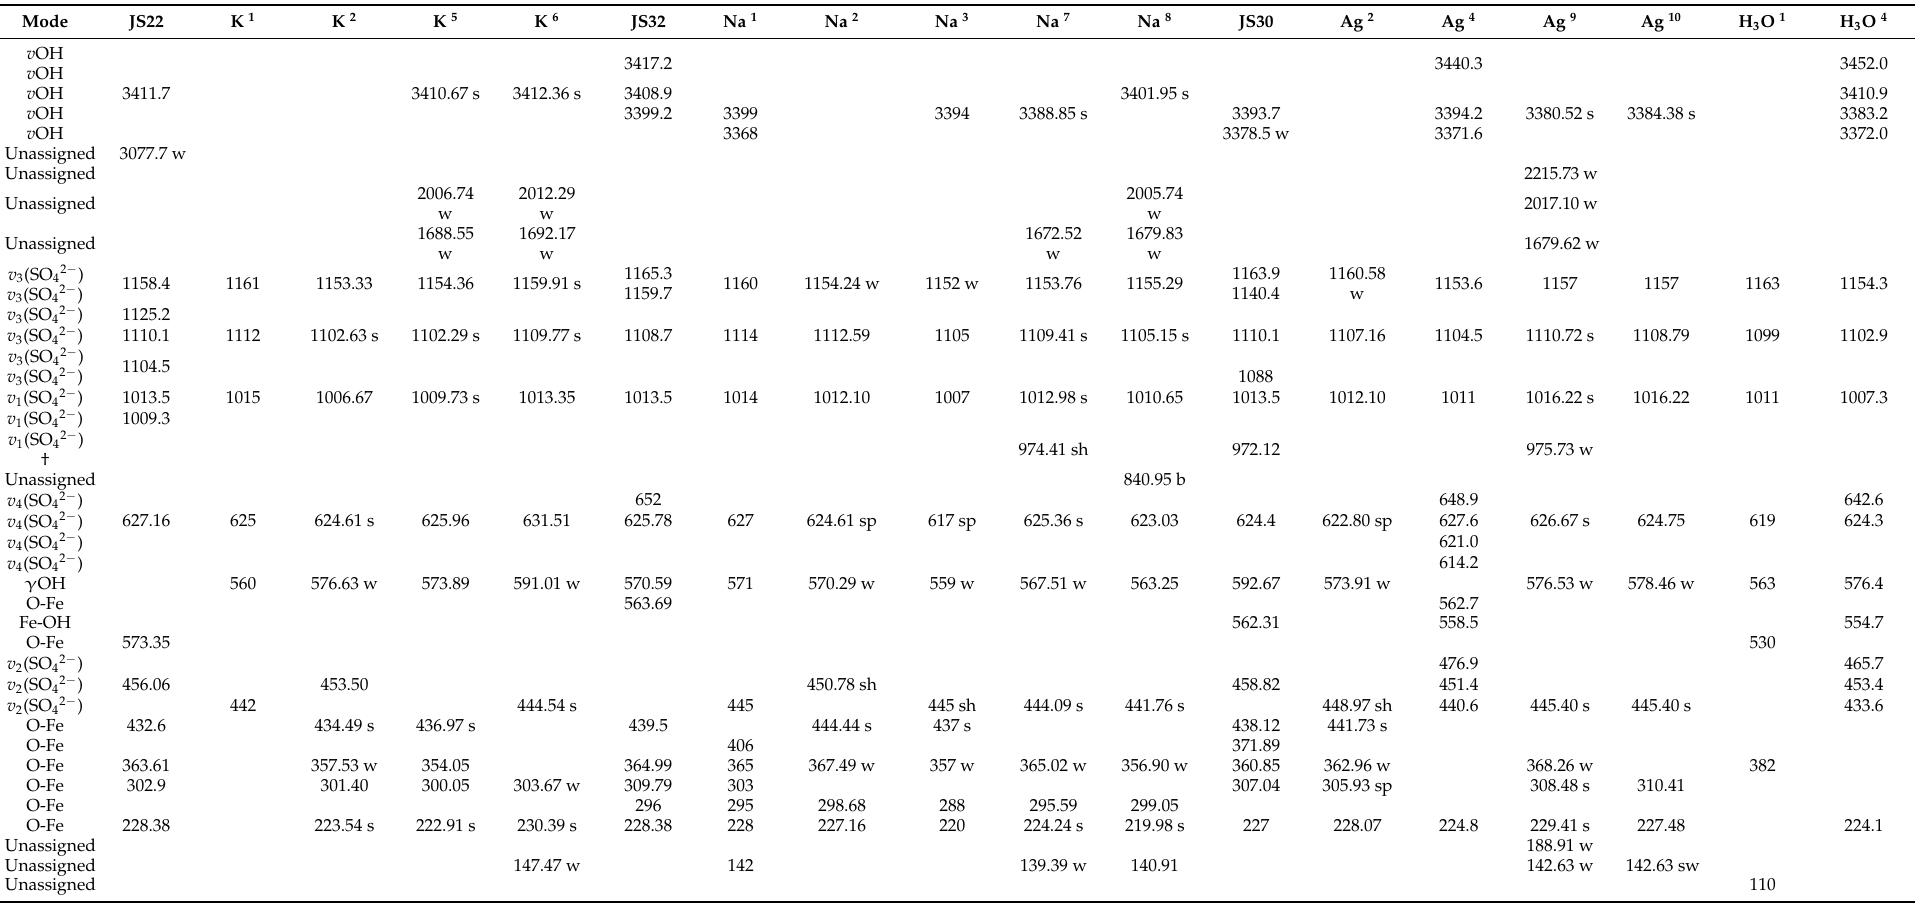
Table 3. Reported Raman frequencies (wavenumbers, cm − 1 ) and mode assignments in synthetic jarosite compound end members, and in jarosite-family